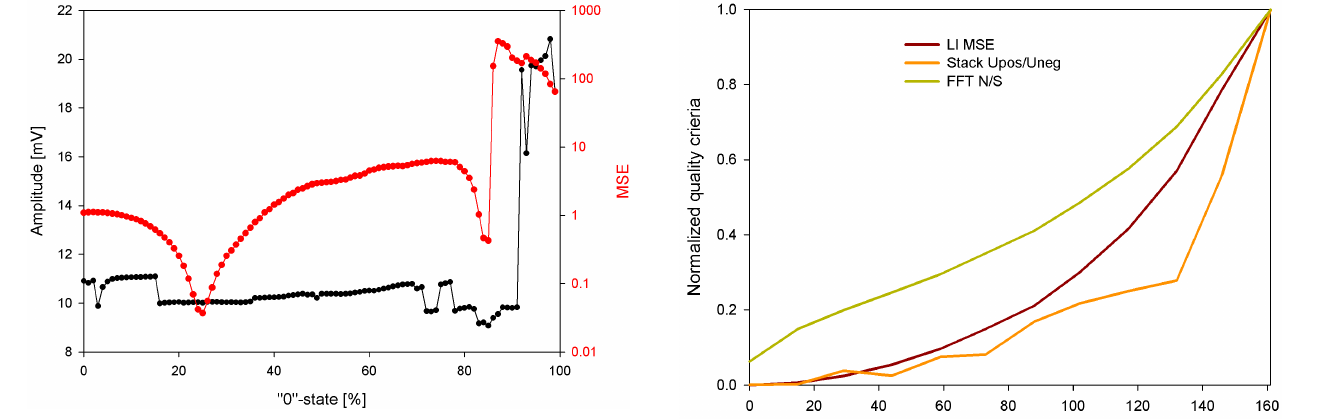
Figure 11. Detected amplitude and mean square error MSE of an ar- tificial signal with 10mV overshoot and 29mVrms pink noise over length of 0 state, showing the plateau between 16 and 35%. Up to 16% 0 state is the effect of the overshoot; above 70% is the reduced noise rejection.